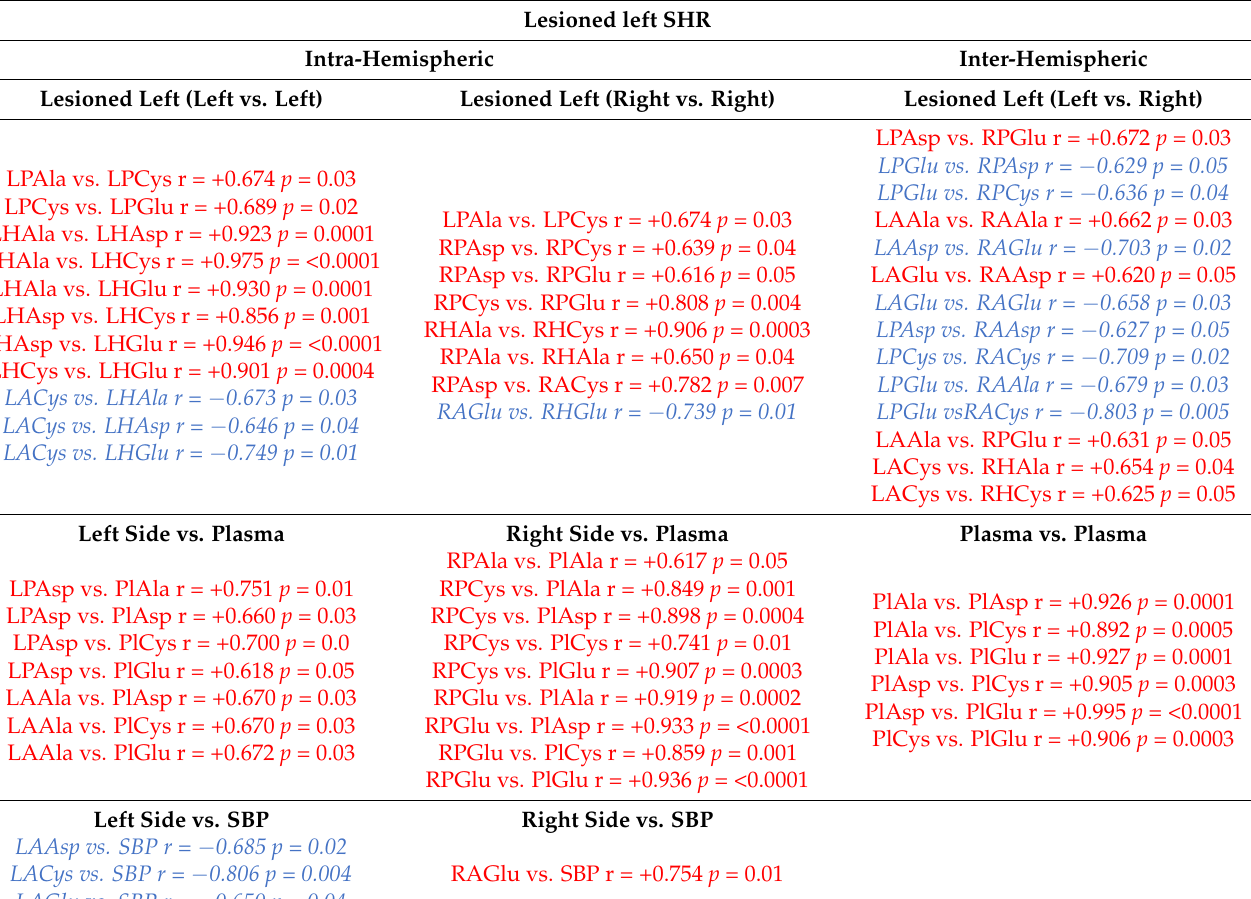
Table 3. Intra- and inter-hemispheric correlations between brain aminopeptidase activities; be- tween plasma aminopeptidase activities; between plasma aminopeptidase activities versus brain aminopeptidase activities and between aminopeptidase activities versus systolic blood pressure (SBP) in lesioned left spontaneously hypertensive rats (SHR). Lesioned left SHR Intra-Hemispheric Inter-Hemispheric Lesioned Left (Right vs. Right) Lesioned Left (Left vs.